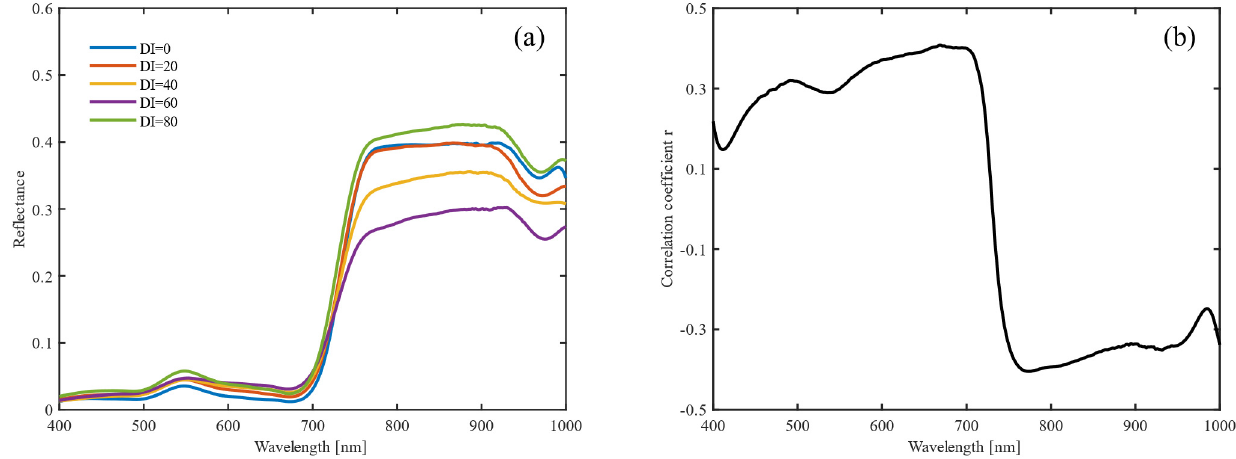
Figure 4. Spectral reflectance changes ( a ) of wheat canopy and its correlation ( b ) with disease index.